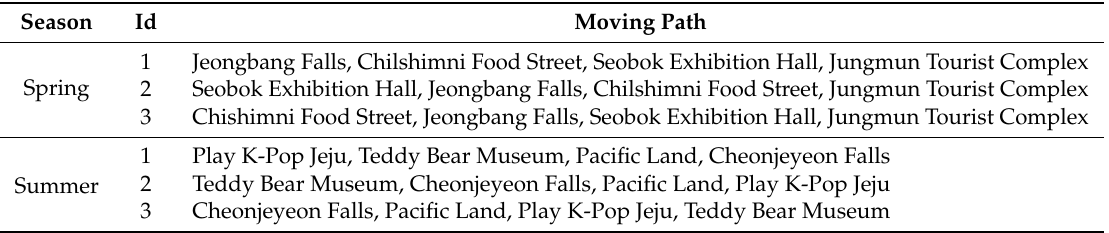
Table 3. A sample of the recommendation in spring and